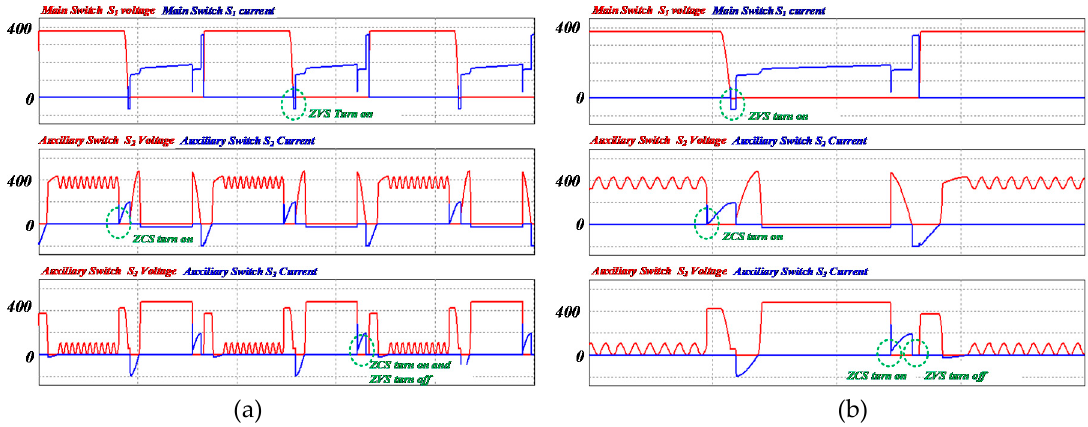
Figure 16. ( a ) Waveforms of voltage and current of each switch and ( b ) expansion waveforms.